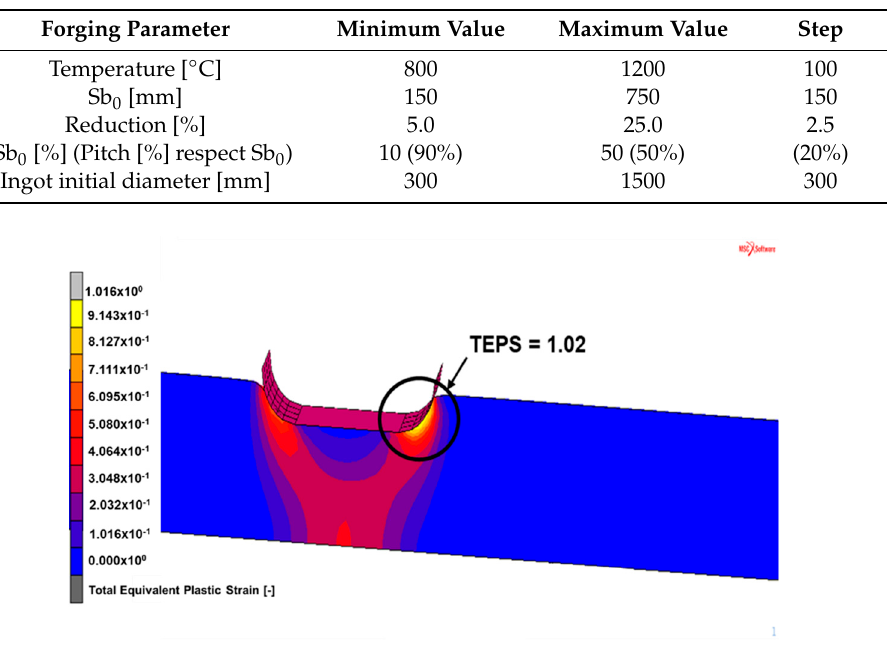
Figure 2. Effect of the presence of manipulator during forging process for a Sb 0 of 300 mm.